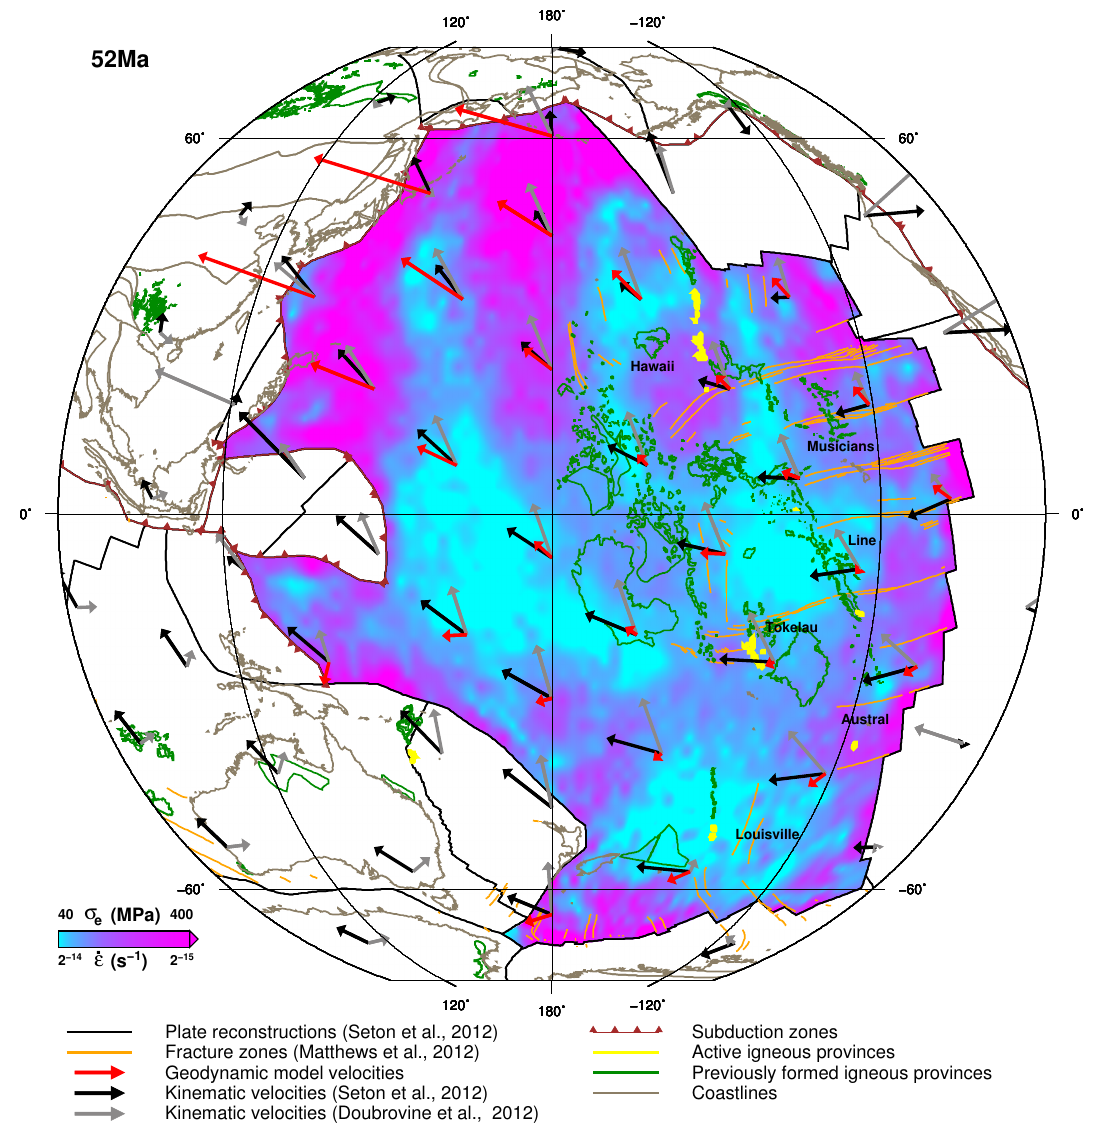
Figure 3. As Fig. 2 but for the Pacific plate reconstruction and model output at 52Ma.